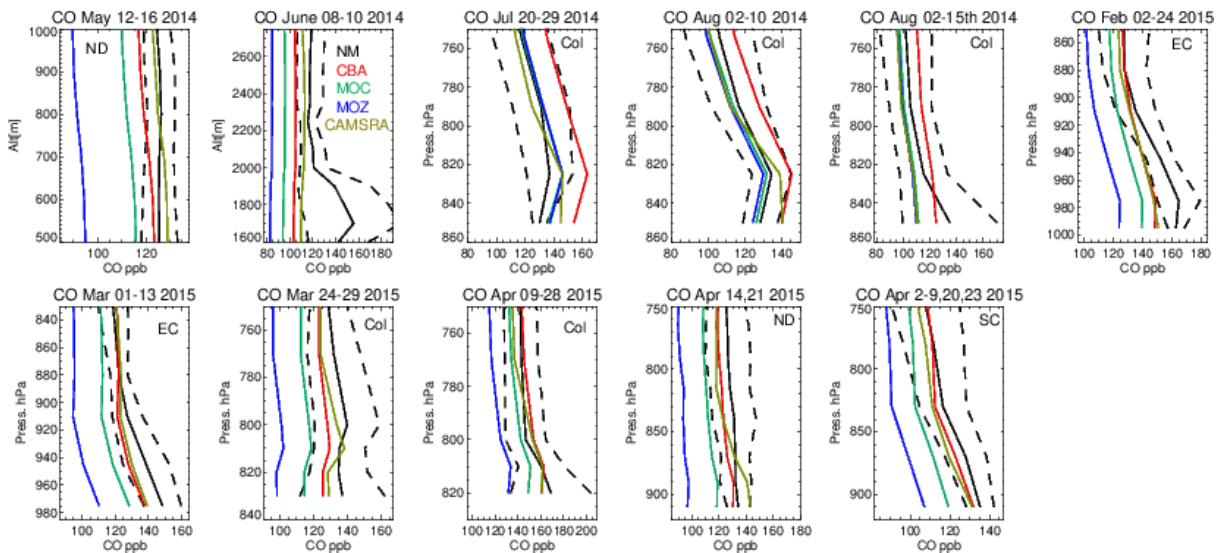
Figure 10. The same as Fig. 6 but for tropospheric CO. Campaigns shown (top left to bottom right) are TOPDOWN, DISCOVER-AQ, FRAPPE, WINTER and SONGNEX.